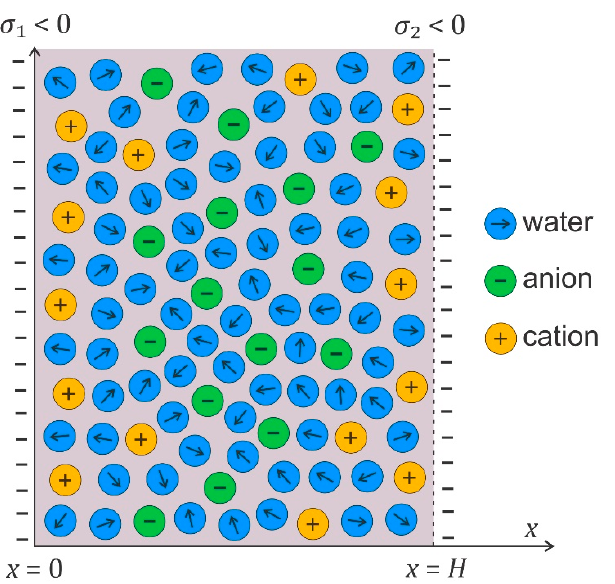
Figure 2. A schematic figure of the electrolyte solution between two charged surfaces at the distance 𝐻 . The surface charge densities of both surfaces are negative, 𝜎 (cid:2869) < 0 and 𝜎 (cid:2870) < 0